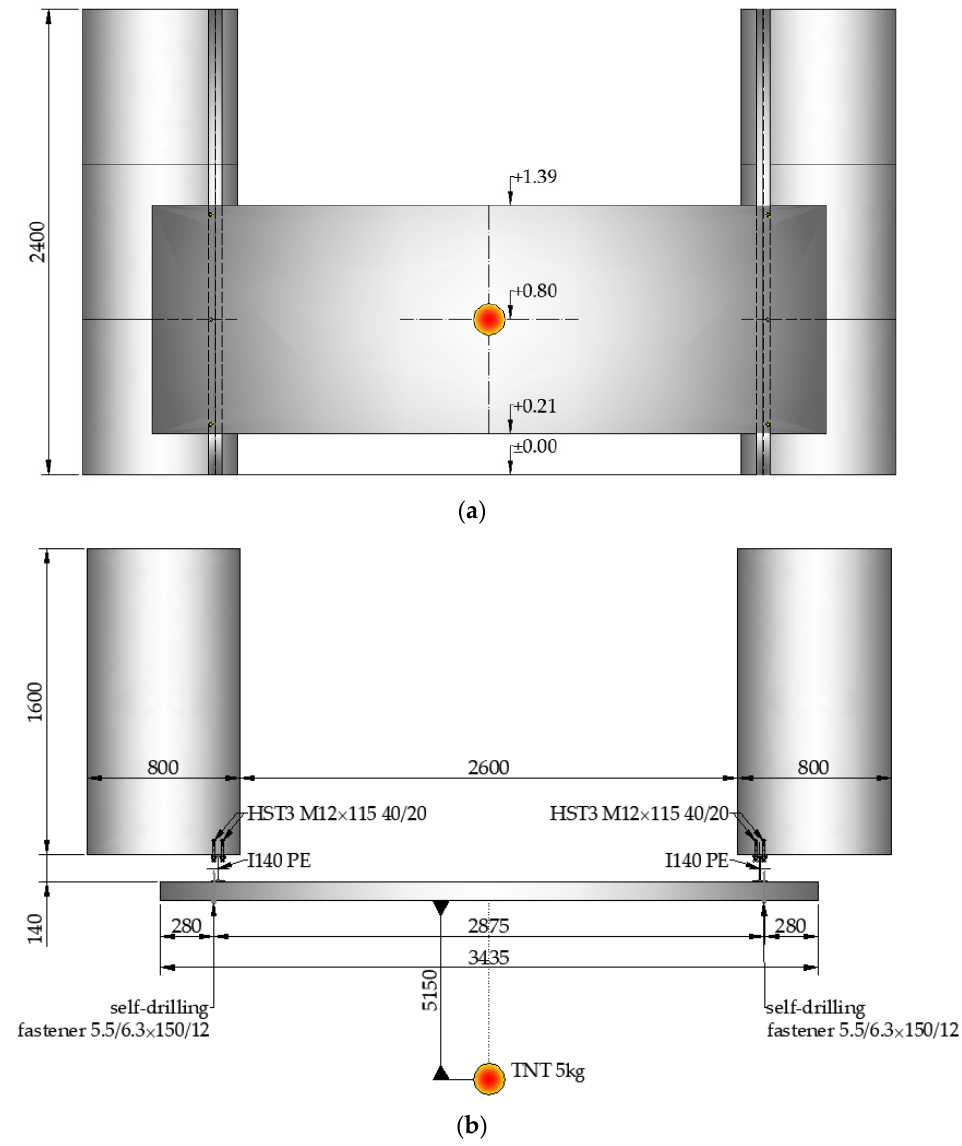
Figure 4. Scheme of the field test (dimensions are in mm): ( a ) front view and ( b ) top view.